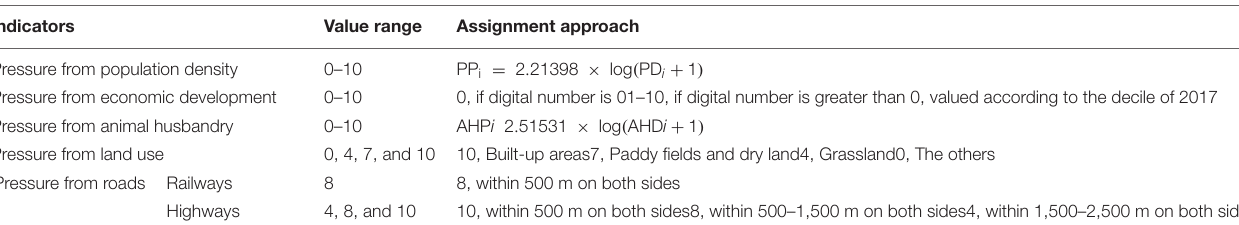
FIGURE 1 | KBAs and NNRs in the Qinghai–Tibet Plateau. TABLE 1 | Evaluation of each type of